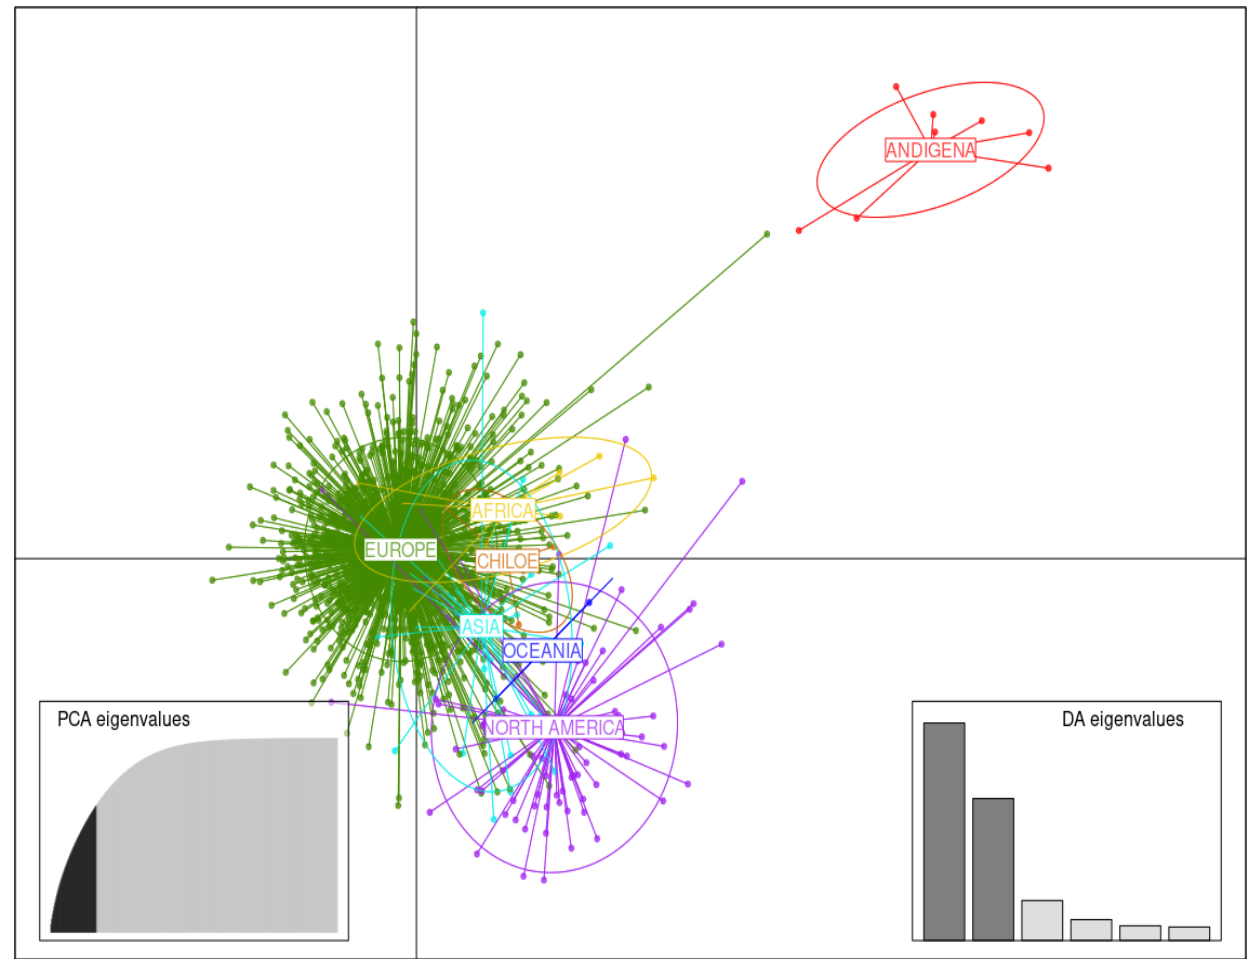
Figure 4. Discriminant analysis of principal components (DAPC) for the germplasm of 1219 potato accessions of various continental origins. The axes correspond to the first two linear discriminants (LD). Each ellipse represents a continent cluster (Africa, Asia, Europe, North America, Oceania, and South America (divided between Andigena accessions and accessions from Chiloe Island)) and each point represents an individual.